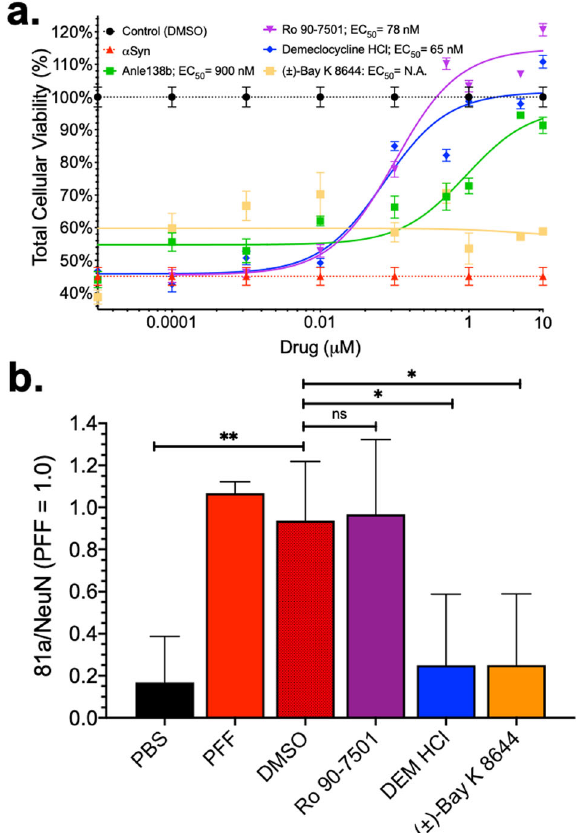
Fig. 8 Cytotoxicity in SH-SY5Y cells and primary neuron pathol- ogy model demonstrate hit compound rescue of α SN induce pathology. a Overexpression of α SN in SH-SY5Y cells results in reduced cellular viability (~44%, red dashed line) as determined by CytoTox-Glo cytotoxicity assay. Treatment with control compound Anle138b as well as hit compounds RO and DEM demonstrate a dose-dependent rescue of toxicity with an EC 50 of 900, 78, and 65 nM for Anle138b, RO, and DEM, respectively. Biosensor hit BAY did not rescue the SH-SY5Y cell toxicity. b Using an α SN PFF-induced pathology model in primary mouse neurons, we evaluated the capacity of our hit compounds to rescue α SN PFF seed-associated pathology (phospho-S 129 staining). PFFs were treated at ~415 ng. Two of our hit compounds reduced the α SN pathology (BAY and DEM). Representative micrographs of each system are presented in Supplementary Fig. 14 with quanti fi cation of cytotoxicity via NeuN counting in Supplementary Fig. 15. N = 3 independent experiment; * p < 0.05, ** p < 0.01, ns indicates not signi fi